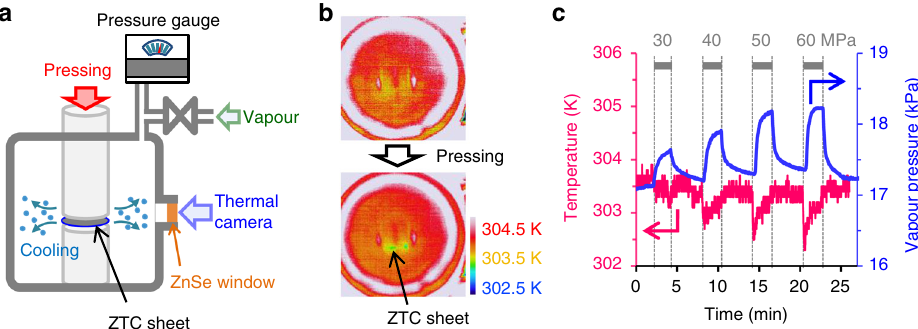
Fig. 7 Temperature change by mechanical force-induced phase transition. a Experimental setup. A ZTC sheet is placed in a closed chamber fi lled with methanol vapour (17 kPa). The temperature of the ZTC sheet can be monitored by an infrared thermal camera through a ZnSe window. The chamber is connected to an automatic adsorption analyser for controlling and monitoring vapour pressure inside the chamber. b Snapshots of the infrared thermal camera without (top) and with (bottom) pressing the ZTC sheet. Red, yellow, blue colours correspond to 304.5, 303.5 and 302.5K, respectively. c The change of methanol vapour pressure (blue line) and temperature of ZTC (red line) when compression (30, 40, 50 and 60 MPa) and release are